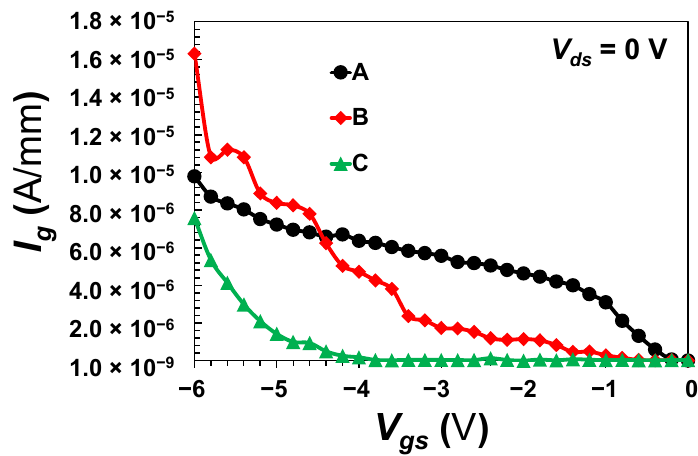
Figure 9. The gate leakage as a function of the applied voltage at the gate terminal.